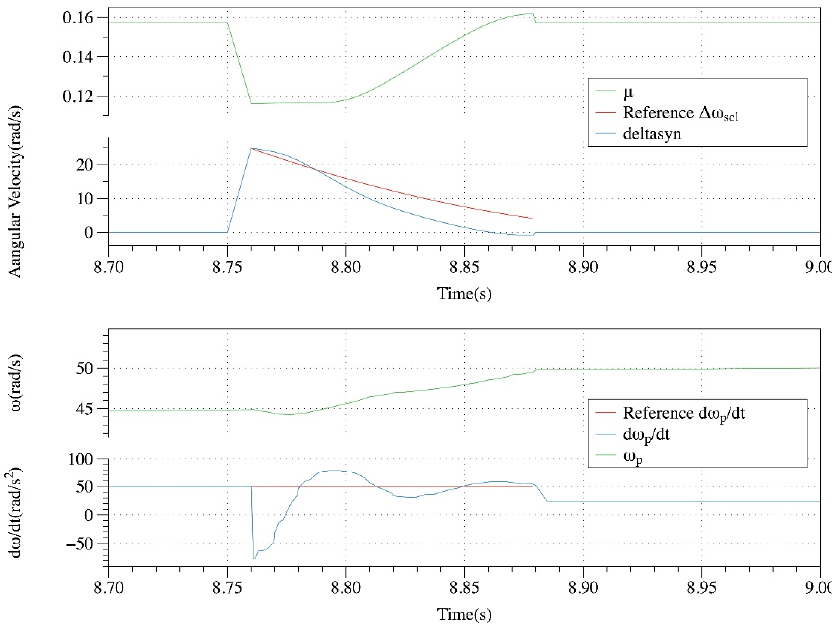
Figure 17. The shifting performance with 8    and change of  well estimated.